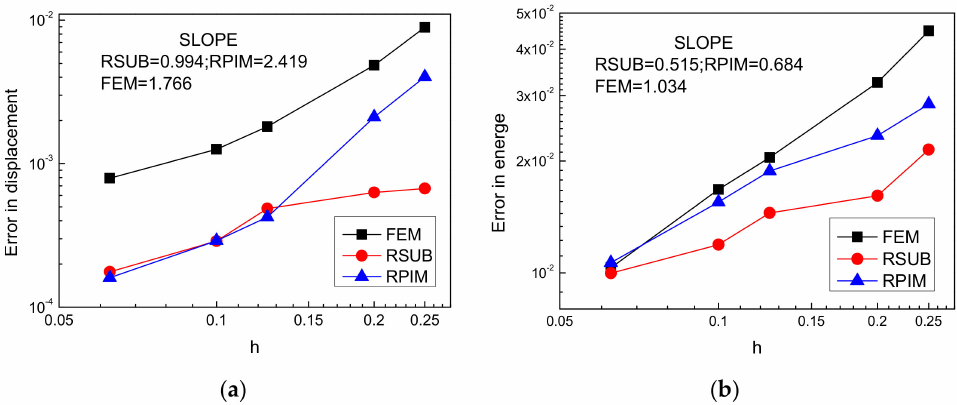
Figure 12. Convergence in the problem of the plate with a hole: ( a ) displacement; ( b )